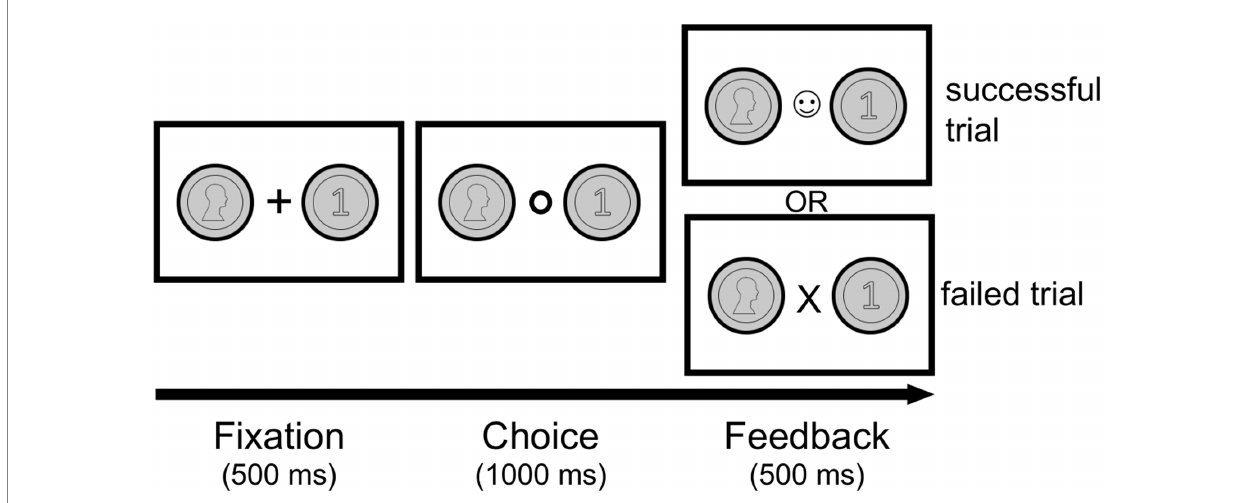
FIGURE 1 Example trial in the experiment. After a brief fixation phase (500 ms) follows the decision phase (1,000 ms), where the participant has to make a choice using the left or right keyboard arrow. The subsequent feedback phase (500 ms) indicates the timing of the button press. If the key is pressed on time, the circle turns into a smiley (successful trial). If the key is pressed too late, the circle turns into an X (failed trial).